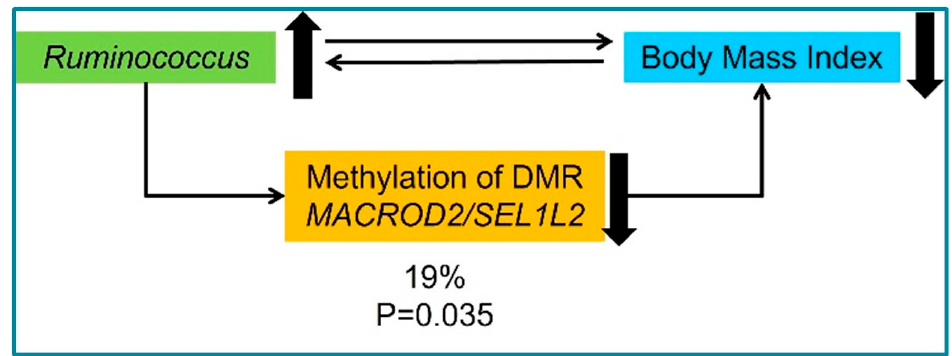
Figure 2. Mediation analysis. Mediation by MACROD2/SEL1L2 DMR DNA methylation in the relationship between Ruminococcus abundance and BMI.